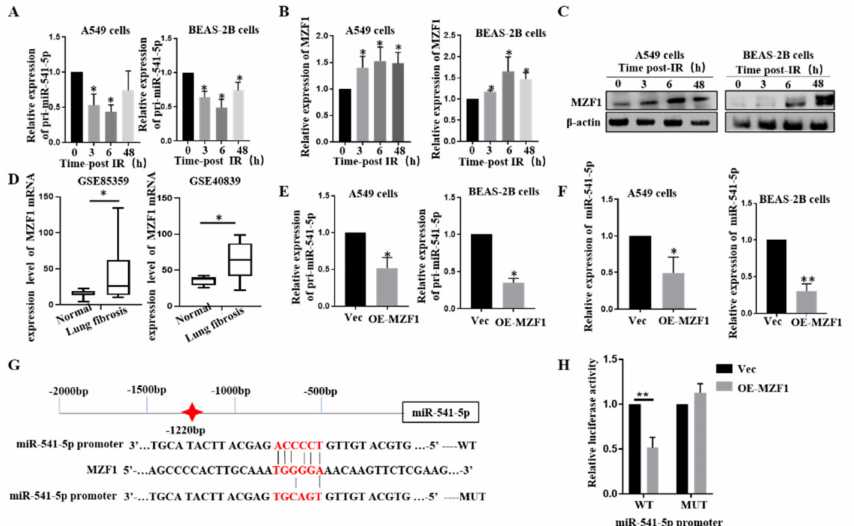
Figure 5. The transcription factor MZF1 regulated the expression of miR–541–5p upon IR. ( A ) The expression of pri–miR–541–5p was detected using RT–qPCR at 0, 3, 6, and 48 h after irradiation. Changes in the expression of ( B ) MZF1 mRNA and ( C ) MZF1 protein in A549 and BEAS–2B cells at 0, 3, 6, and 48 h after 6 Gy irradiation, detected using RT–qPCR and Western blot analysis. ( D ) Comparison of MZF1 mRNA in lung tissues between a normal population and lung fibrosis patients (GSE40839) or mice (GSE85359) from NCBI (https://www.ncbi.nlm.nih.gov/ accessed on 18 October 2021). Overexpression of MZF1 in A549 cells and BEAS–2B cells followed by detection of ( E ) pri–miR–541–5p and ( F ) miR–541–5p using RT–qPCR. ( G ) Predicting the binding site for the binding between MZF1 and the miR–541–5p promoter region using the JASPAR database. ( H ) Co– transfection of the miR–541–5p promoter WT (wild type)/MUT (mutant) and the